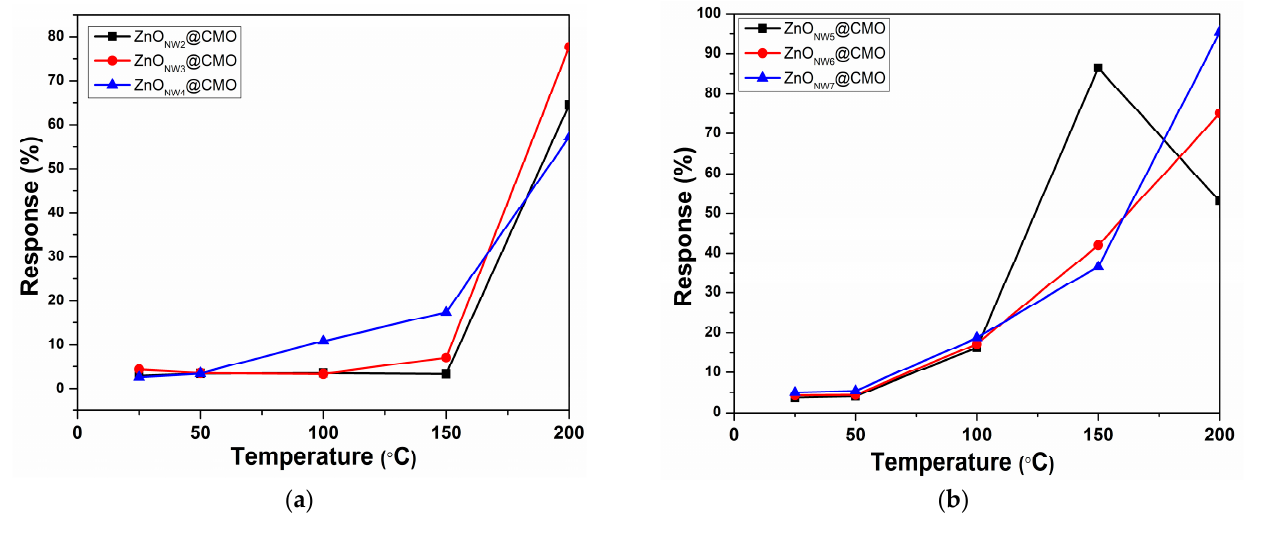
Figure 8. Diagram of the testing temperature and response of ZnO Nws @CMO sensors at Zn foil oxidation temperature of 350 °C ( a ) and 400 °C ( b ). Table 3. Different structures for CO and CO 2